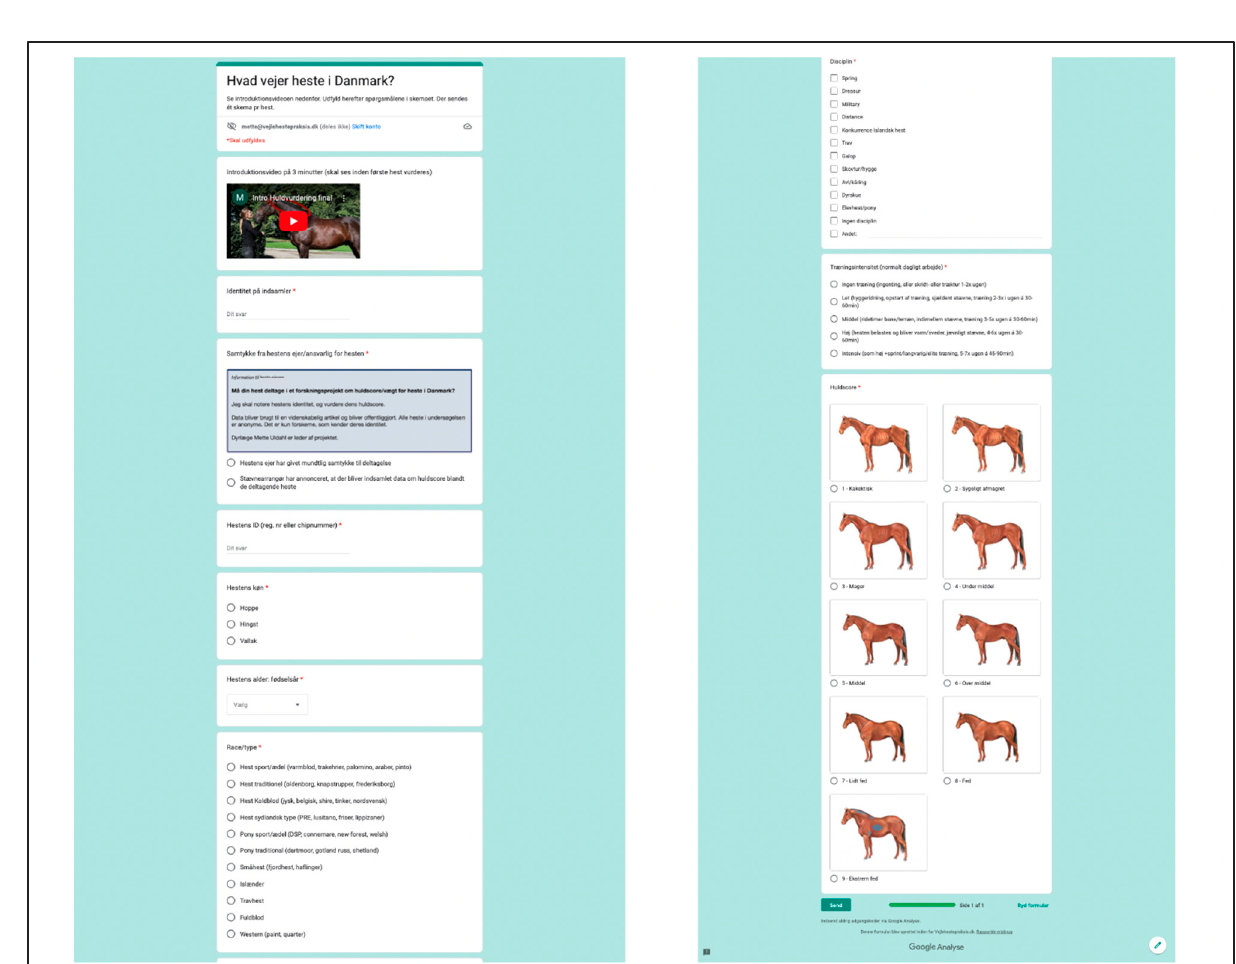
Figure A1. PDF copy of the survey questionnaire.